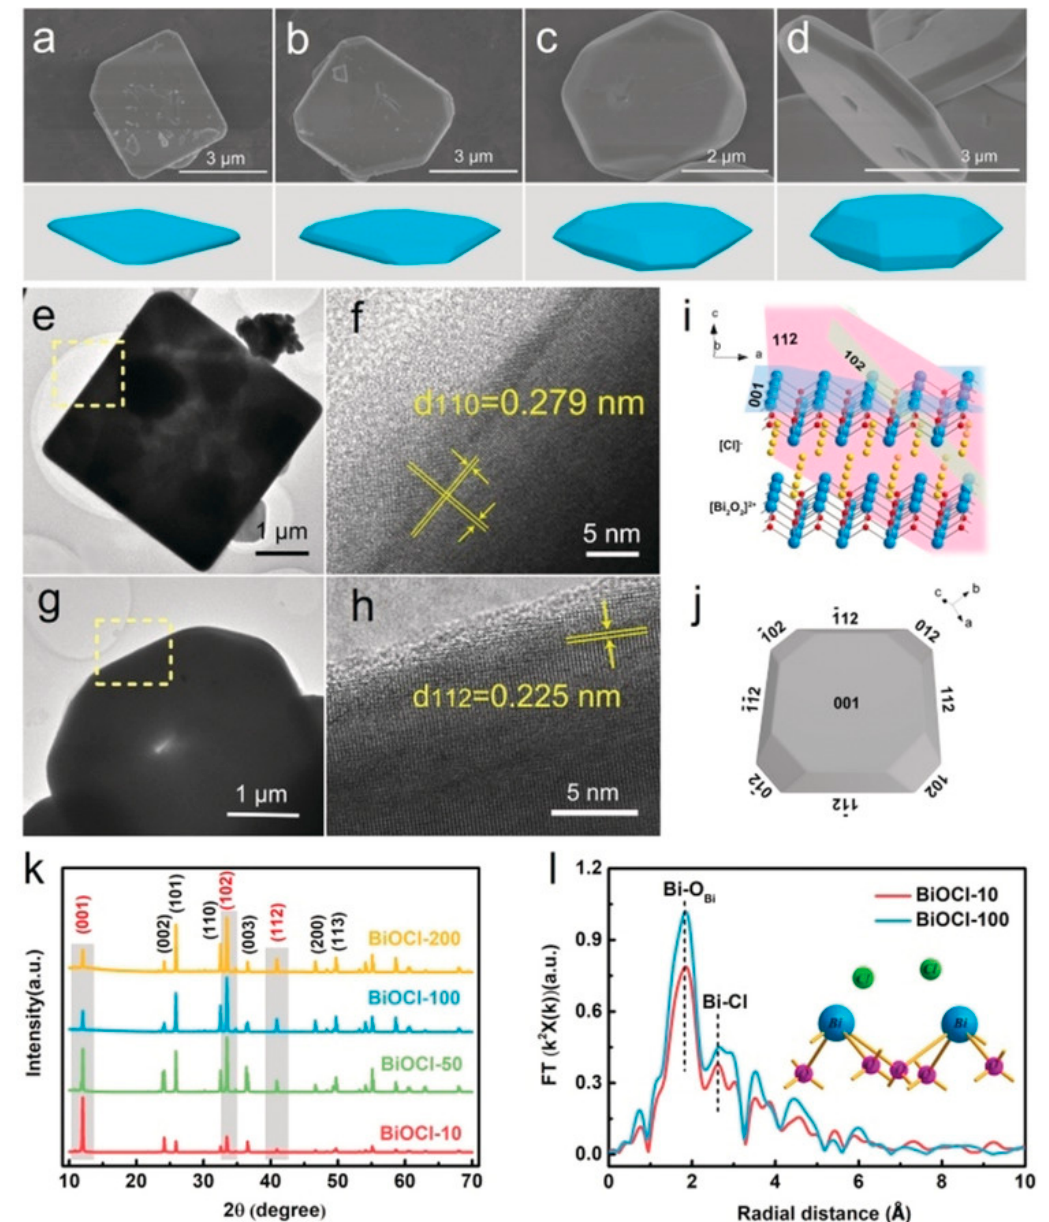
Figure 11. SEM images and the corresponding schematic representation for BiOCl treated at different time intervals ( a ) 10 h, ( b ) 50 h, ( c ) 100 h, and ( d ) 200h; ( e ) TEM image and ( f ) HRTEM image of BiOCl treated for 10 h; ( g ) spherical aberration correction TEM image and ( h ) HRTEM image of BiOCl treated for 100 h; ( i ) crystal structure and facets of BiOCl; ( j ) Schematic representation of the different facets of eighteen-faceted BiOCl; ( k ) XRD patterns of BiOCl series samples; ( l ) Fourier transformed profiles for Bi coordination environments in normalized Bi L3-edge XAFS spectra of BiOCl treated at 10 and 100 h. Reprinted from Ref. [192] with permission from John Wiley & Sons.